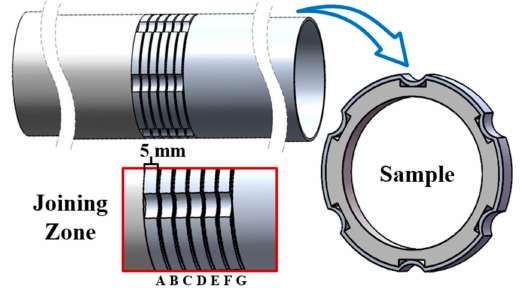
Figure 4. Specimen of microscopic observation.